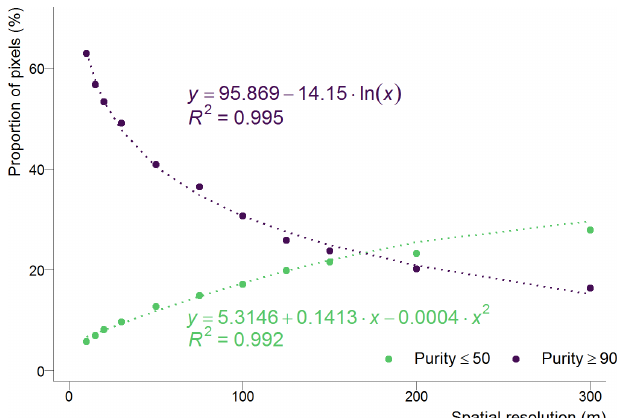
Figure 8. Proportions of the purity index values for different spatial resolutions. The purple line indicates pixels with a purity above 90% and the green line shows pixels with a purity of less than